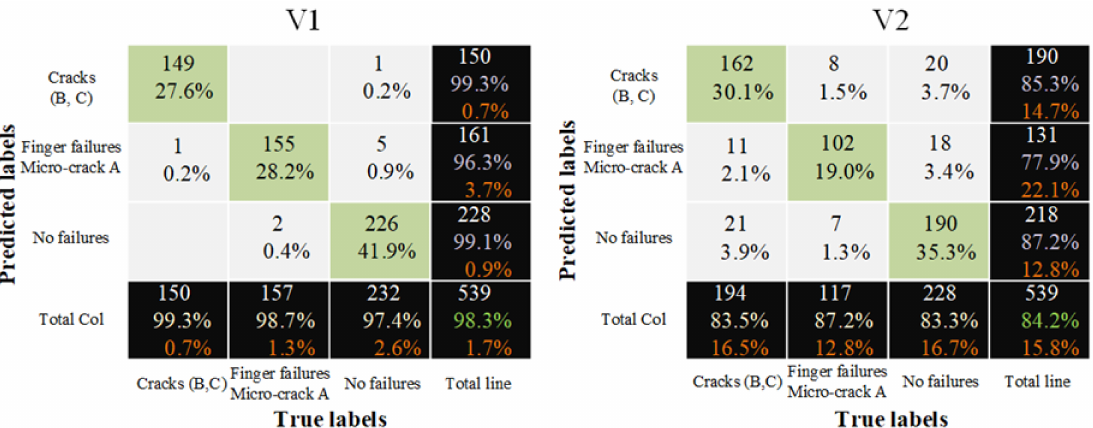
Figure A1. Confusion matrices of the implemented feature vectors ( V1 , V2 ) fed as an input to the RF ML